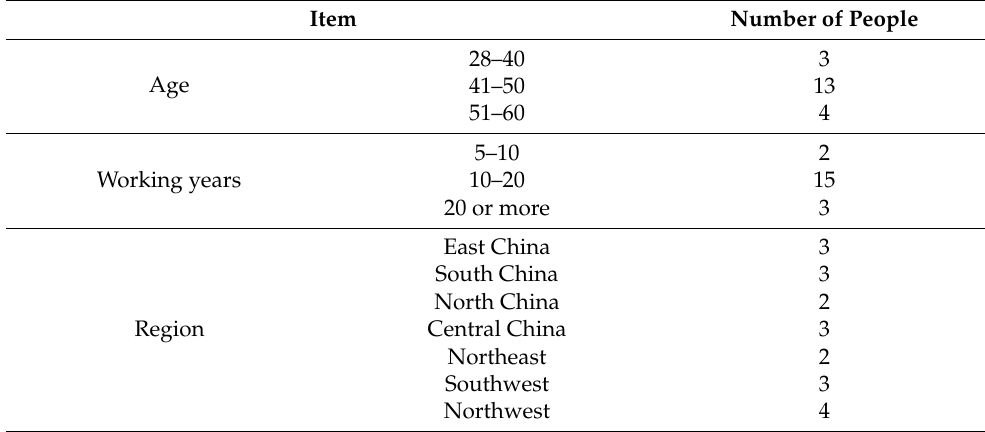
Table 3. Basic information of